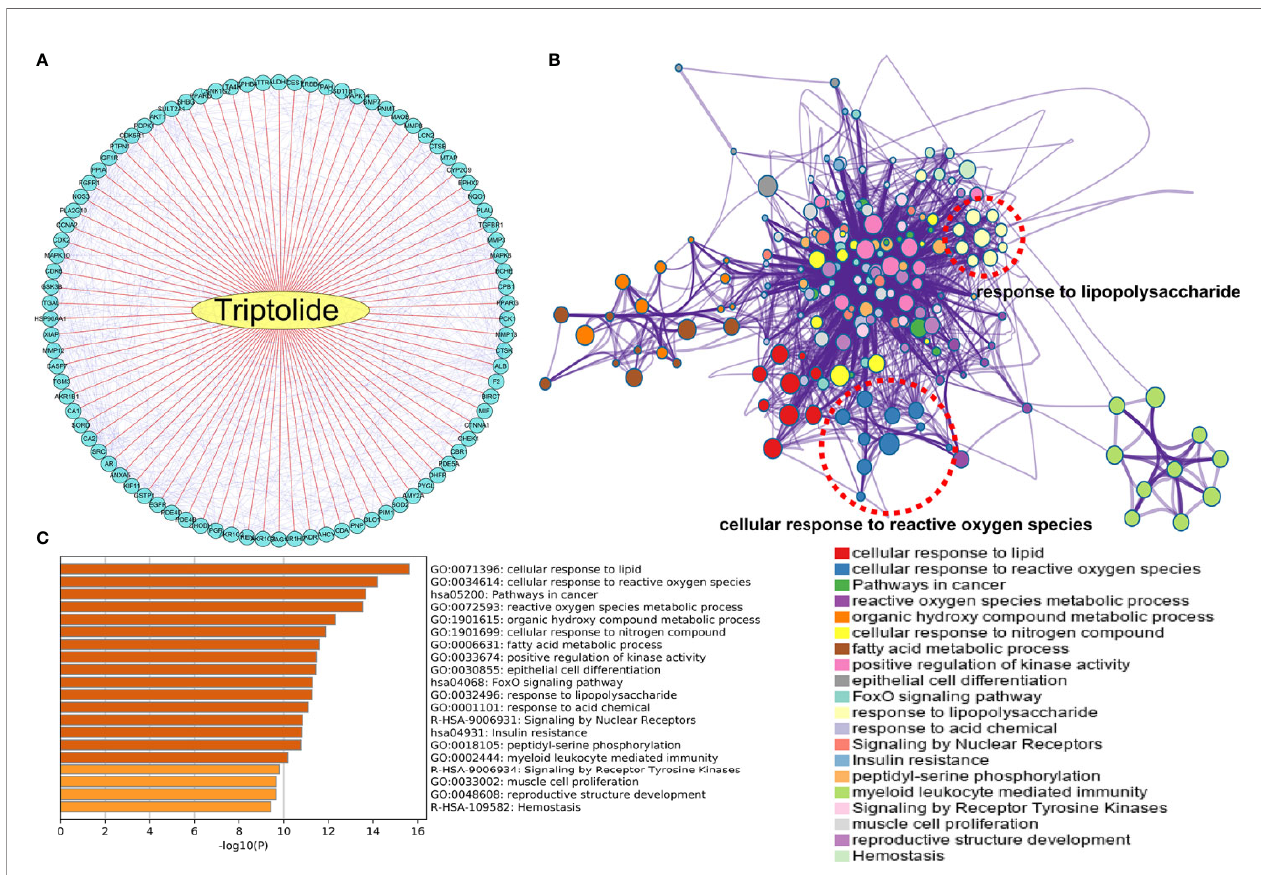
FIGURE 4 | The underlying target of triptolide by network pharmacology analysis. (A) The potential targets of triptolide were analyzed by the PharmMapper website. The (B) PPI network and (C) heatmap showed the regulated top 10 KEGG and GO signaling pathways of triptolide by the Metascape